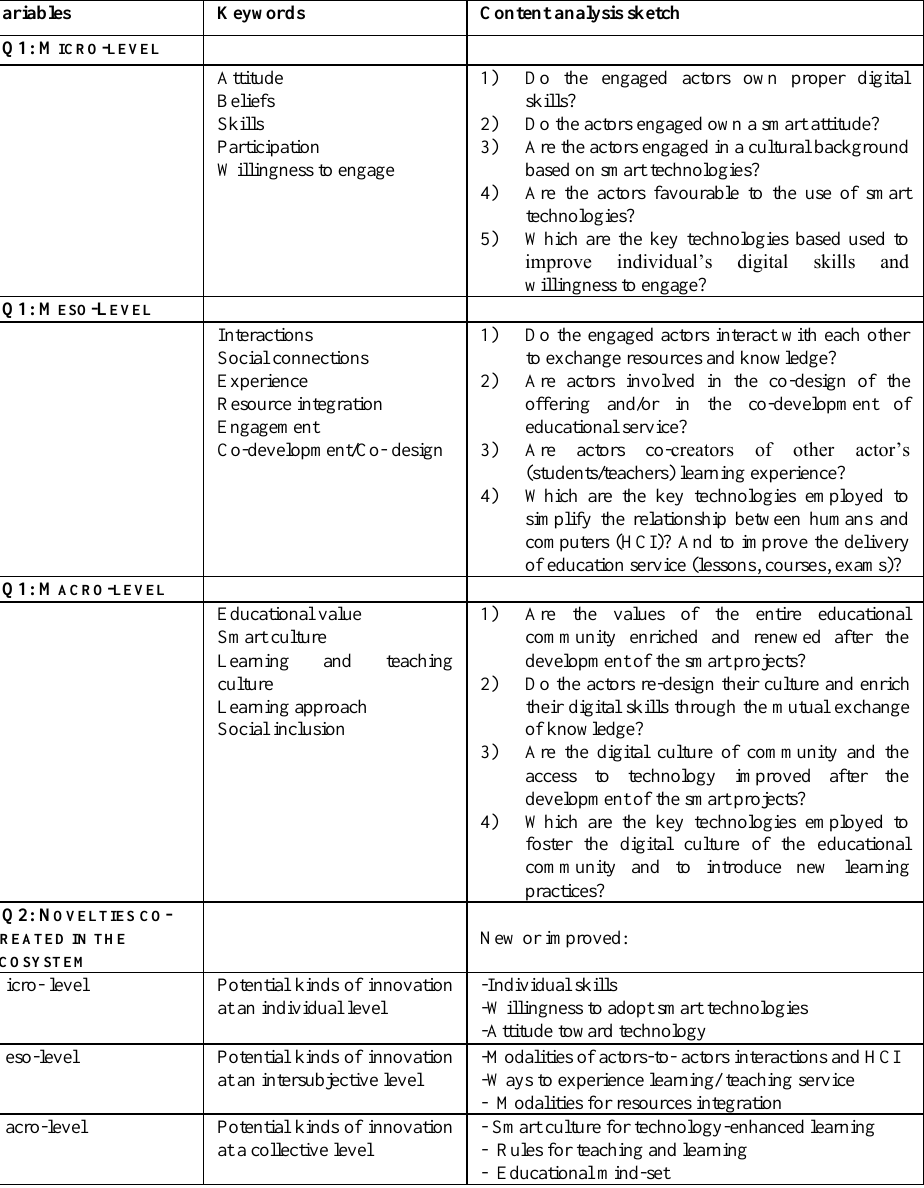
Table 1. Variables, keywords and content analysis sketch (source: author’s